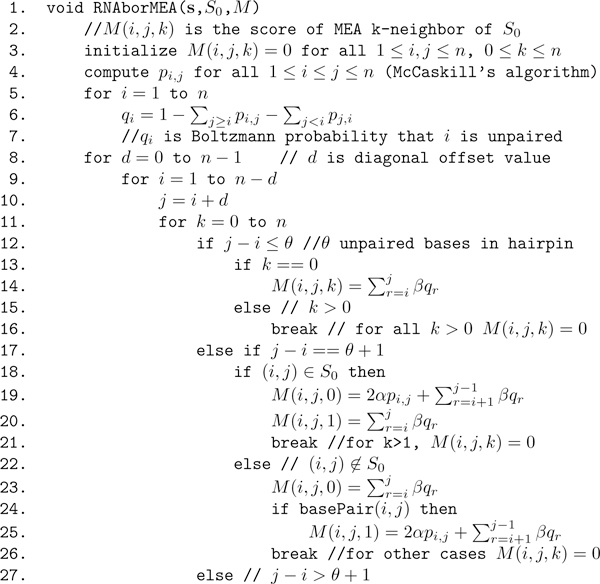
Initial portion of pseudocode for RNAborMEAalgorithm, which continues in Figure 11. Given RNA sequence s = s1, .. .,sn of length n, initial secondary structure S0 of s, RNAborMEA computes for all values of 0 ≤ k ≤ n that structure S with base pair distance k from S0, which maximizes the value M(i,j,k)= ∑(i,j)∈S2αpi,j+∑iunpaired in sβqi. The pseudocode actually computes only values M(i, j, k) for all i, j, k; the MEA structures are obtained by backtracing. This algorithm clearly runs in O(n5) time with O(n3) space.